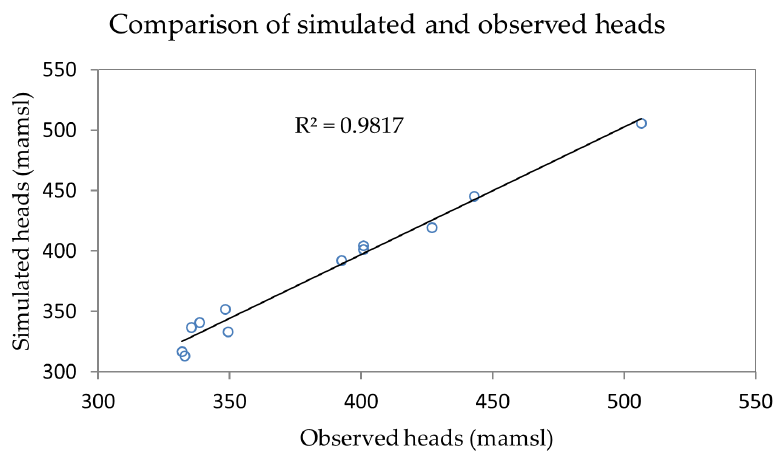
Figure 8. Simulated and observed hydraulic heads in meters above mean sea level based on the steady-state calibration in the Klela basin.